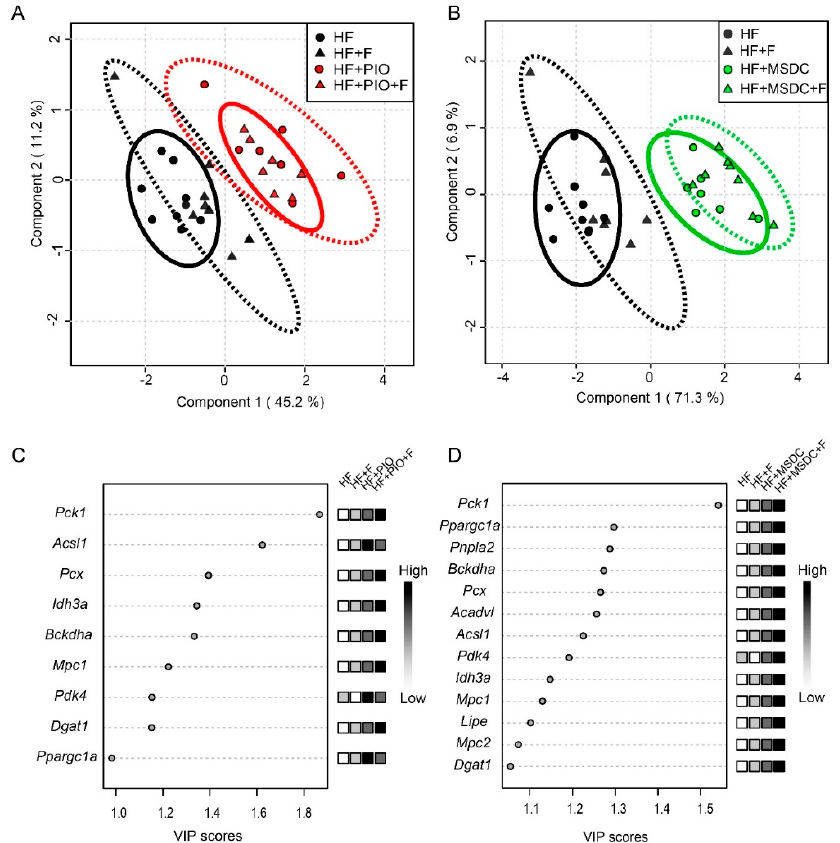
Figure 7. Multivariate analysis of gene expression in eWAT. Mice were fed various HF diets for 8 weeks. Expression of a total of 24 selected genes in eWAT was analyzed using PLS-DA (only genes with the expression level above background in all the groups were considered—i.e., all the genes in Figure 8, except for Ucp1. Score plots resulting from the analysis focus on the separation of the HF, HF + F, HF + PIO and HF + PIO + F mice ( A ), and the HF, HF + F, HF + MSDC and HF + MSDC + F mice ( B ). The corresponding variable importance in projection (VIP) plot with scores for identifying the most discriminating transcripts, with VIP > 1.0, is shown in ( C ) for ( A ), and in ( D ) for ( B ). The colored boxes indicate the relative expressions of the genes in each group. For designation of dietary groups, see Section